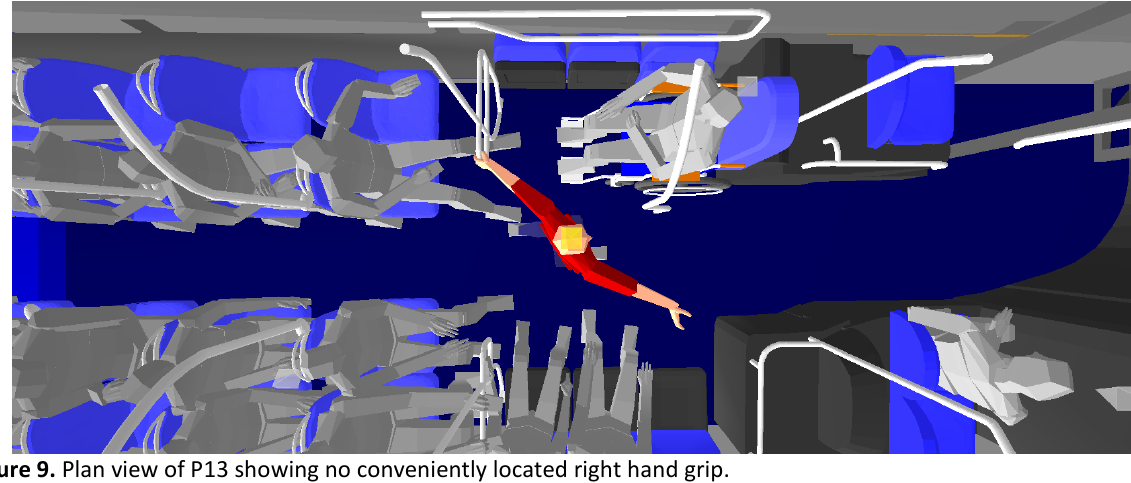
Figure 9. Plan view of P13 showing no conveniently located right hand grip.